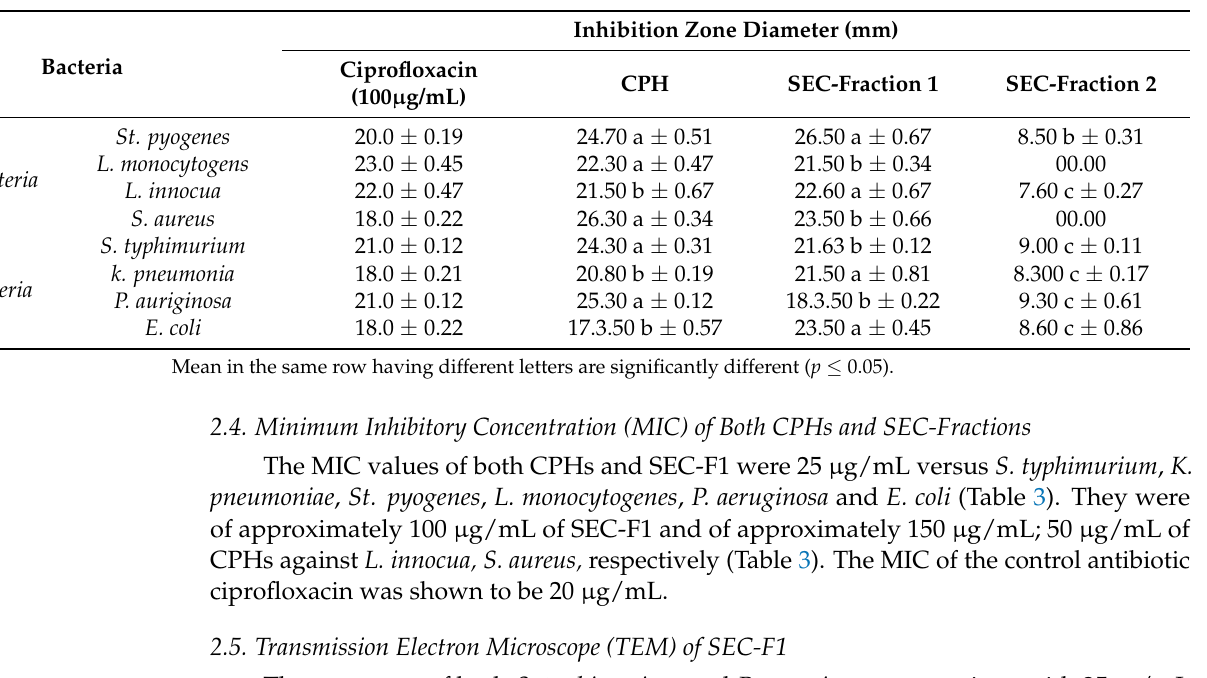
Table 2. Antibacterial activity of cowpea protein hydrolysate (CPH) and size exclusion chromatography (SEC) fractions (1 and 2) against tested bacteria.